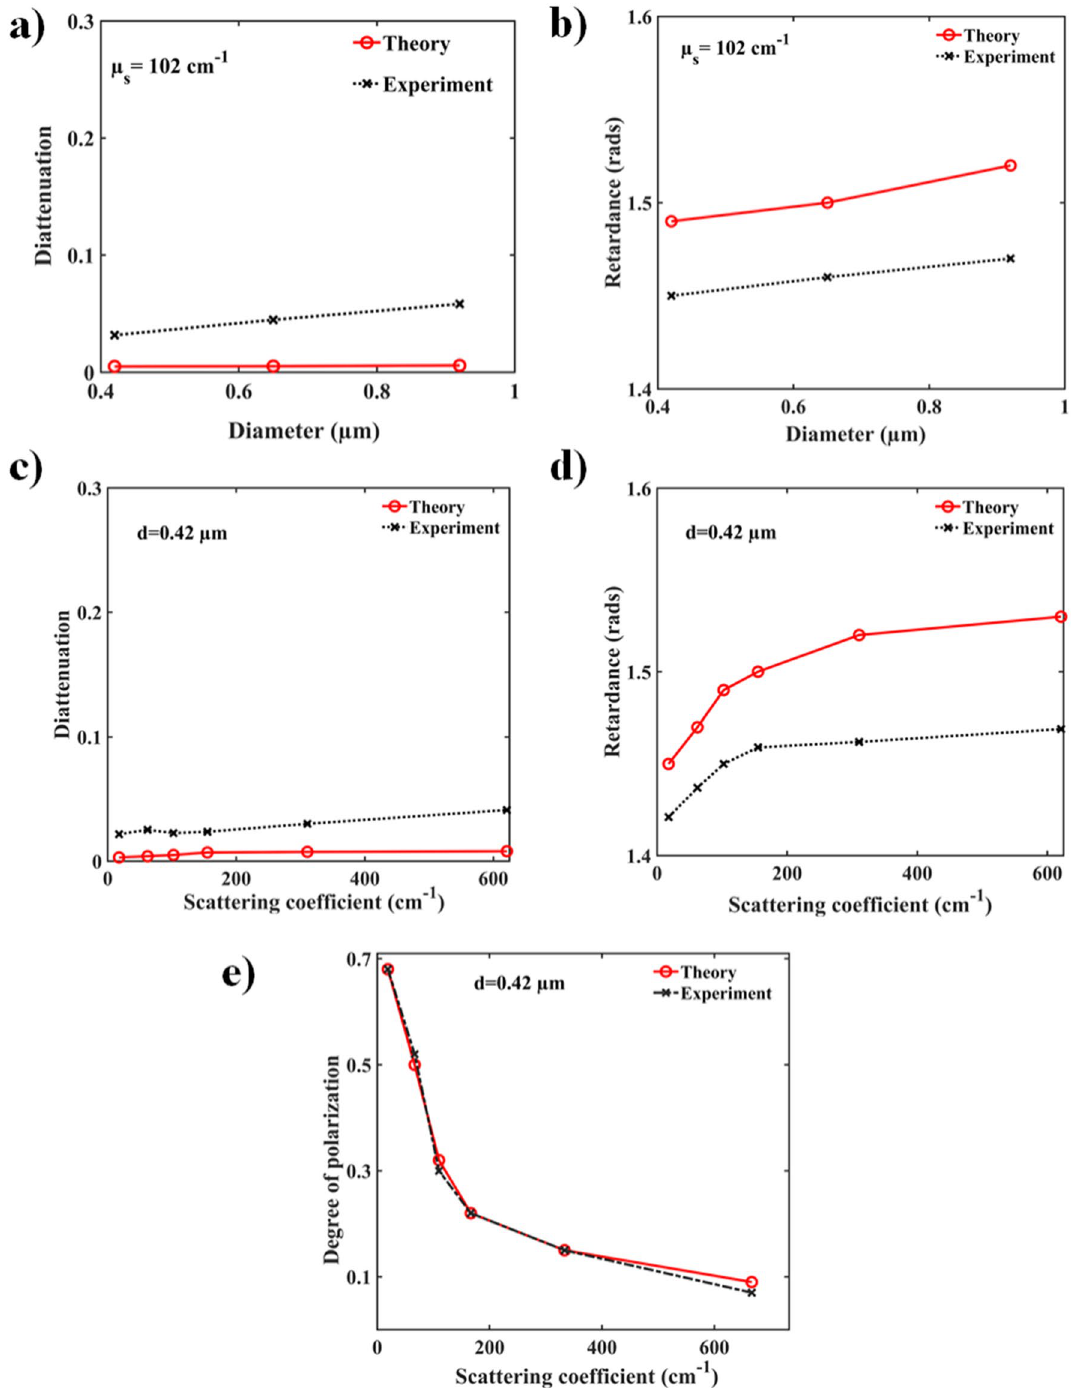
Figure 2. Polarization effects in microspheres-only phantom system. Dependence of the Mueller matrix- derived polarization parameters of a controlled turbid media (microsphere phantom) on the diameter and scattering coefficient. MC-simulated (red symbols) and experimentally obtained (black symbols) variations of the ( a ) diattenuation and ( b ) retardance with microsphere diameters for a fixed scattering coefficient 1 . Near zero diattenuation stems from isotropic nature of the spherical scatterers, and non-zero 102 cm µ S − = 1.5 radians) likely arises from the detection geometry effects and particle diameters (for details, retardance ( ∼ see text). The simulated (red symbols) and experimental (black symbols) variations of ( c ) diattenuation and ( d ) retardance with optical turbidity ( µ S range from 16 to 621 cm −1 ) for a fixed scatterer diameter ( d exhibit similar trends of near zero diattenuation and finite retardance (− 1.4 to 1.5 radians). The corresponding variation of the simulated and experimental degree of polarization with turbidity shown in ( e ). Note : in Figs. 2 and 3, symbols are experimental and simulations results, and lines are guides for the